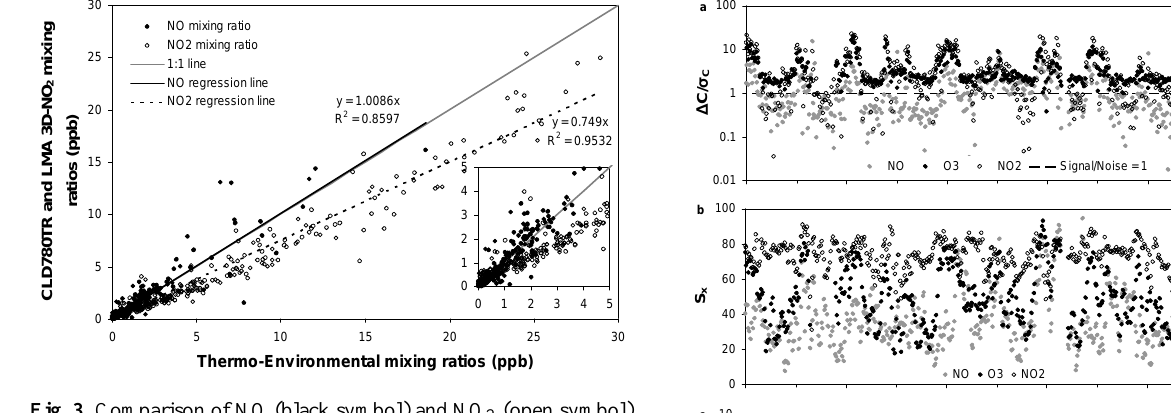
Fig. 3. Comparison of NO (black symbol) and NO 2 (open symbol) Figure 3: Comparison of NO (black symbol) and NO 2 (open symbol) mixing ratios mixing ratios measured at 1.6m height with Thermo-Environmental measured at 1.6 m height with Thermo-Environmental 42i and LMA 3D-NO 2 and 42i and LMA 3D-NO 2 and CLD780TR. Grey line is the 1:1 line, CLD780TR. Grey line is the 1:1 line, black line the regression function for NO and black line the regression function for NO and dotted line the regres- dotted line the regression function for NO 2 . sion function for NO 2 . Table 2. Averaged mixing ratio difference measured between 1.6m and 0.7m and between 0.7m and 0.2m over the entire measurement period for O 3 , NO and NO 2 and for different u ∗ classes.